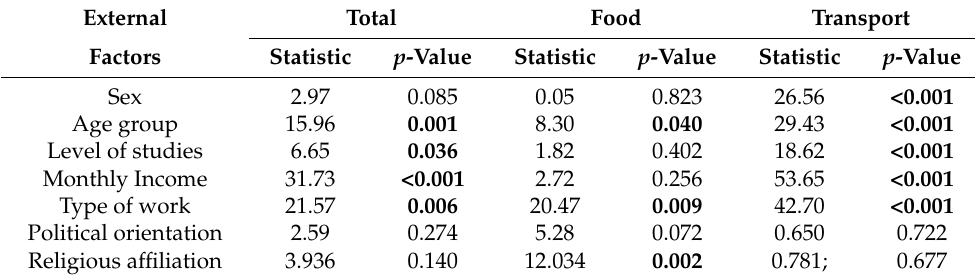
Table 2. Kruskal–Wallis values from testing CF differences between external